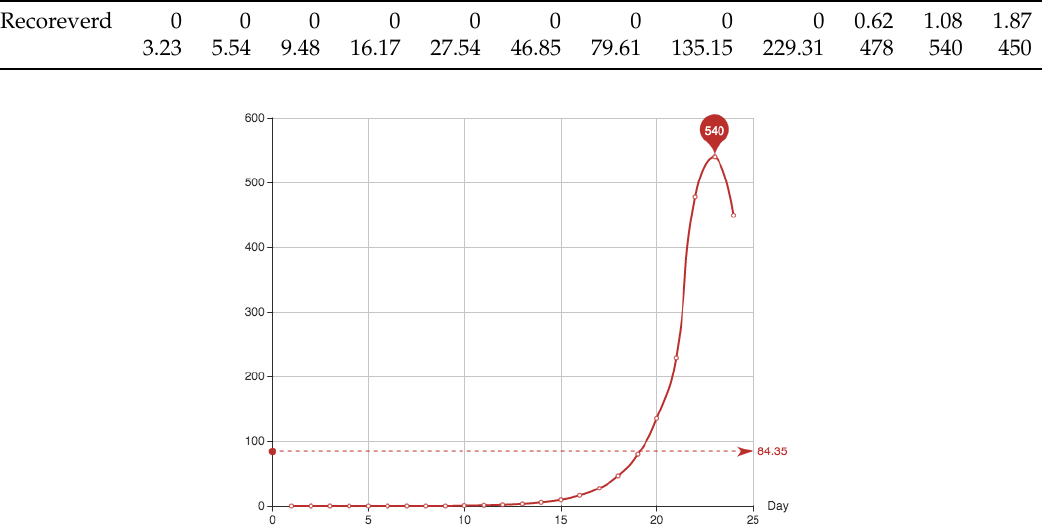
Table 3. Simulation of the recovered patients provided by the function F ( t ) (natural order from left to right).